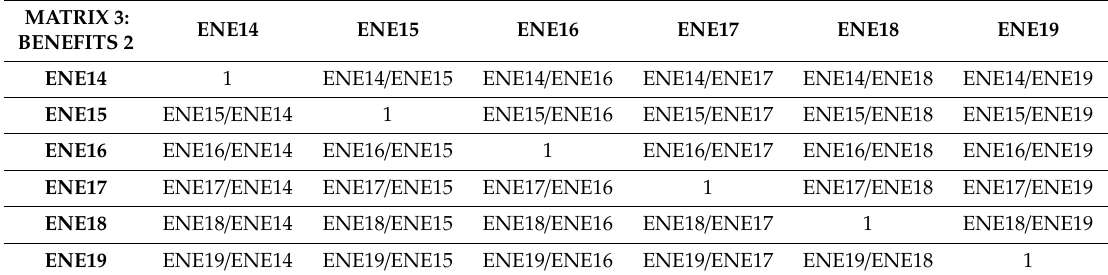
Table 5. Pairwise comparison matrices for Matrix 3 (Benefits Level 2).